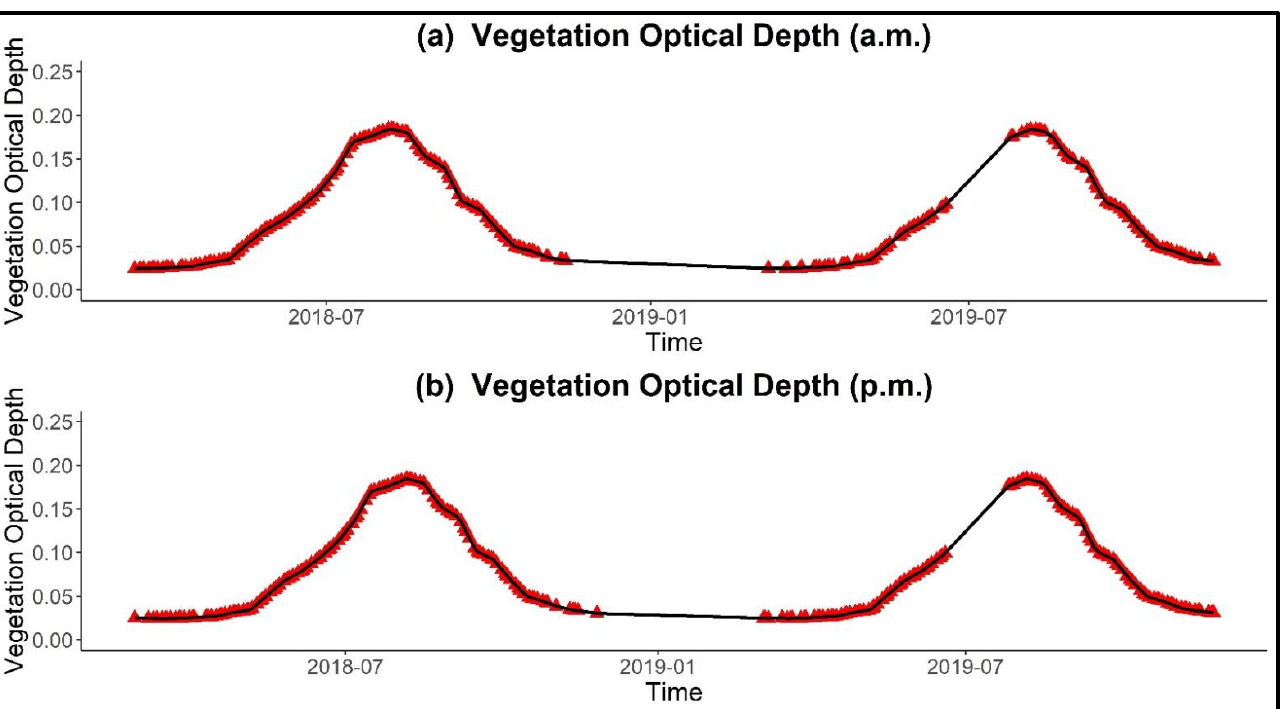
Figure 14. Time-series representation of SMAP-derived vegetation optical depth (dimensionless) of ( a ) SMAP L3 (a.m.) products and ( b ) SMAP L3 (p.m.) products.